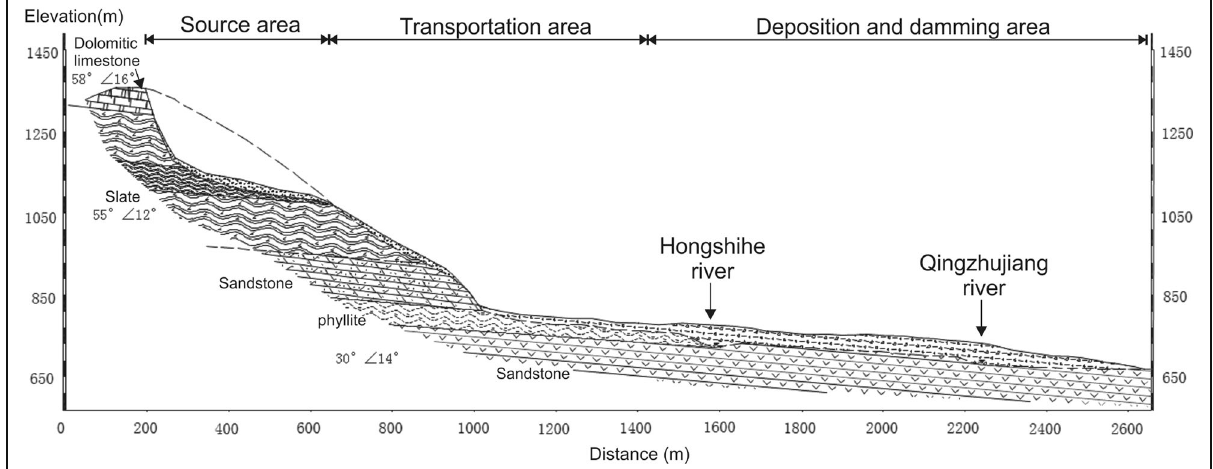
Fig. 8 Geological profile of the Donghekou